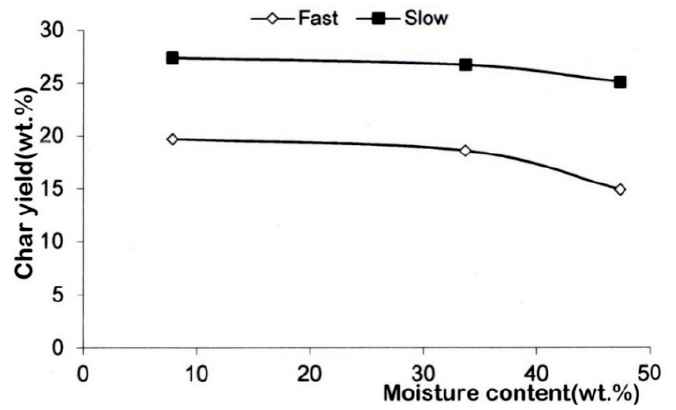
Figure 10. The biochar yield from pyrolysis of WS W , WS PD and WS TD under slow and fast heating rates.